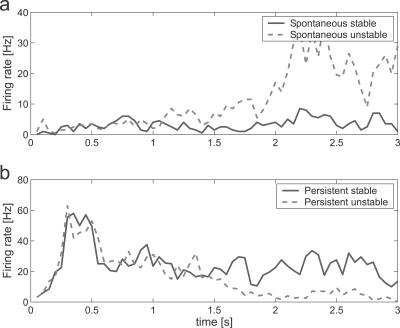
Example Trials of the Integrate-and-Fire Attractor Network Simulations(A) Trials in which no recall stimulus was applied to S1, and spontaneous firing continued until the end of the trial in the “spontaneous” simulation condition. However, on one of the trials illustrated, the firing increased as the network climbed into one of the attractors because of the statistical fluctuations caused by the spiking dynamics.(B) Trials in which a recall stimulus was applied to S1 at 0–500 ms, and continuing firing normally occurred until the end of the trial in the “persistent” simulation condition. However, on one of the trials illustrated, the firing decreased as the network fell out of the attractor because of the statistical fluctuations caused by the spiking dynamics. In these simulations, the network parameter is w+ = 2.1, and the modulation of the synapses is −NMDA and −GABA. This corresponds to a reduction of 4.5% and 9% in the currents produced through these synapses, respectively. The average firing rate of all the neurons in the S1 pool is shown.